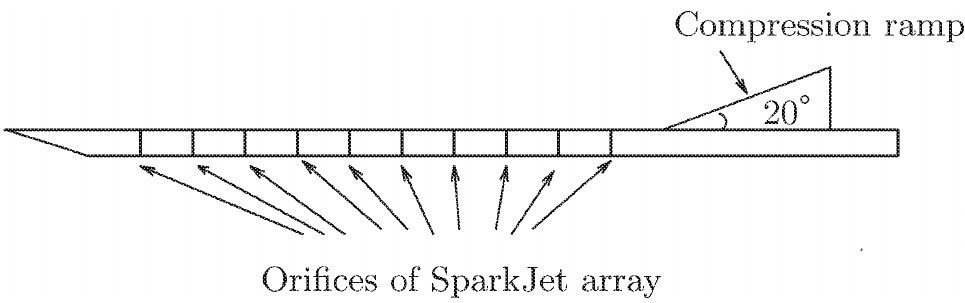
Figure 15. Model